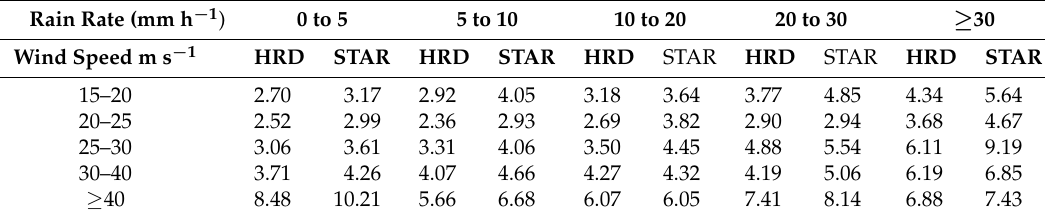
Table 7. Wind-Speed Retrieval Error Standard Deviations for the HRD and STAR Algorithms.